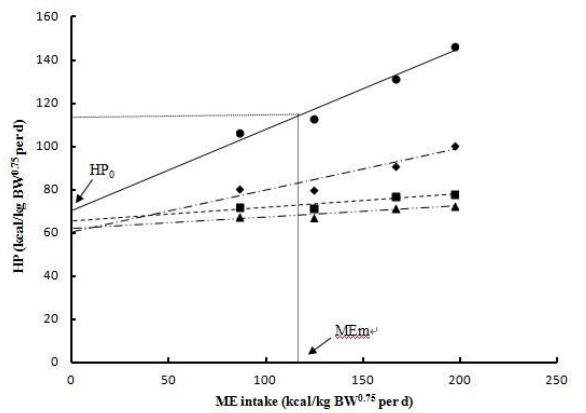
Figure 1. Total heat production (HP,  ) and fasting HP (d 1,  ; d 2, ■; d 3, ▲) in laying hens at four ME intake levels, as well as extrapolated HP at zero ME intake (HP 0 ) and estimated maintenance ME requirements (MEm, where ME intake equals HP, 113.09 kcal/kg BW 0.75 per d) based on linear regression analysis. Values are means. Total HP = 71.02  0.372 ME intake (R 2 = 0.9627); fasting HP (d 1) = 60.78  0.1906 ME intake (R 2 = 0.8662); fasting HP (d 2) = 65.23  0.0645 ME intake (R 2 = 0.8215); fasting HP (d 3) = 62.14  0.0526 ME intake (R 2